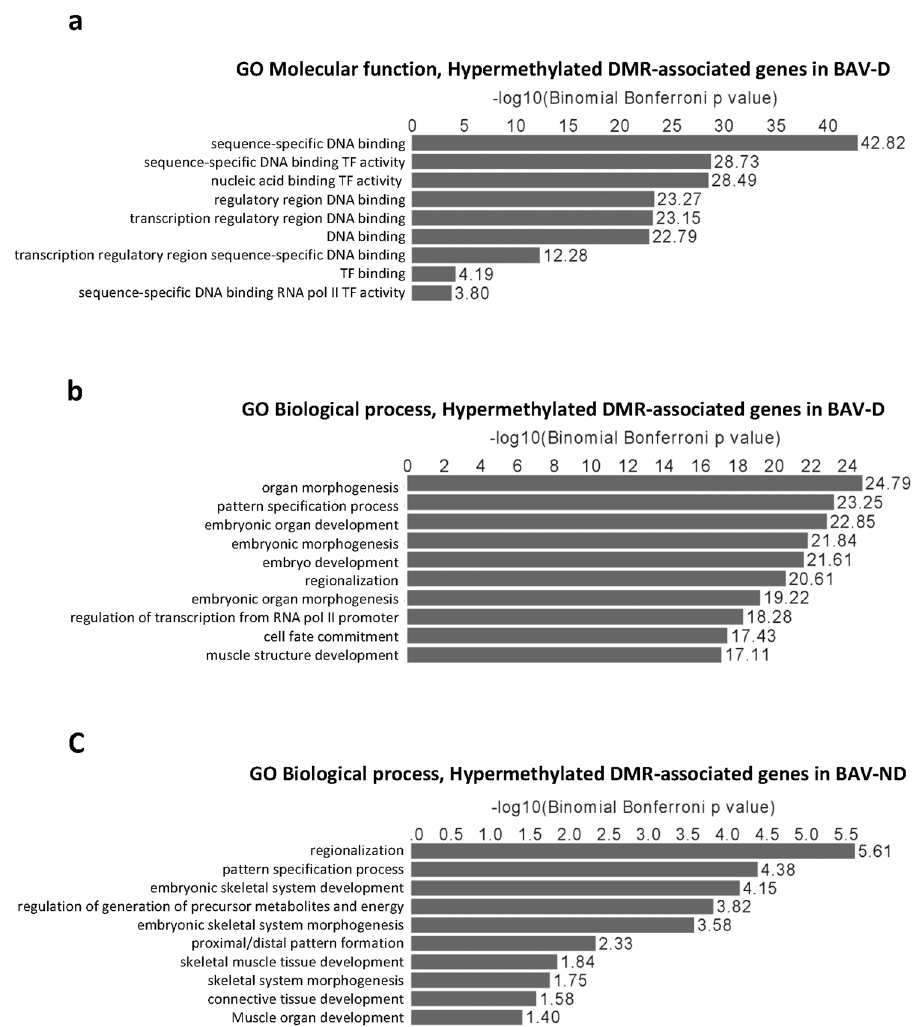
Figure 5. Gene ontology analysis of BAV hypermethylated DMR-associated genes. ( a ) Hypermethylated DMR-associated genes in BAV dilated (D) aorta, Molecular function; ( b ) Hypermethylated DMR- associated genes in BAV-D aorta, Biological processes; ( c ) Hypermethylated DMR- associated genes in BAV non-dilated (ND) aorta, Biological processes. N = 14 BAV-D; N = 13 TAV-D; N = 7 BAV-ND; N = 10 TAV-ND. − Log10 Binominal Bonferroni P-values are